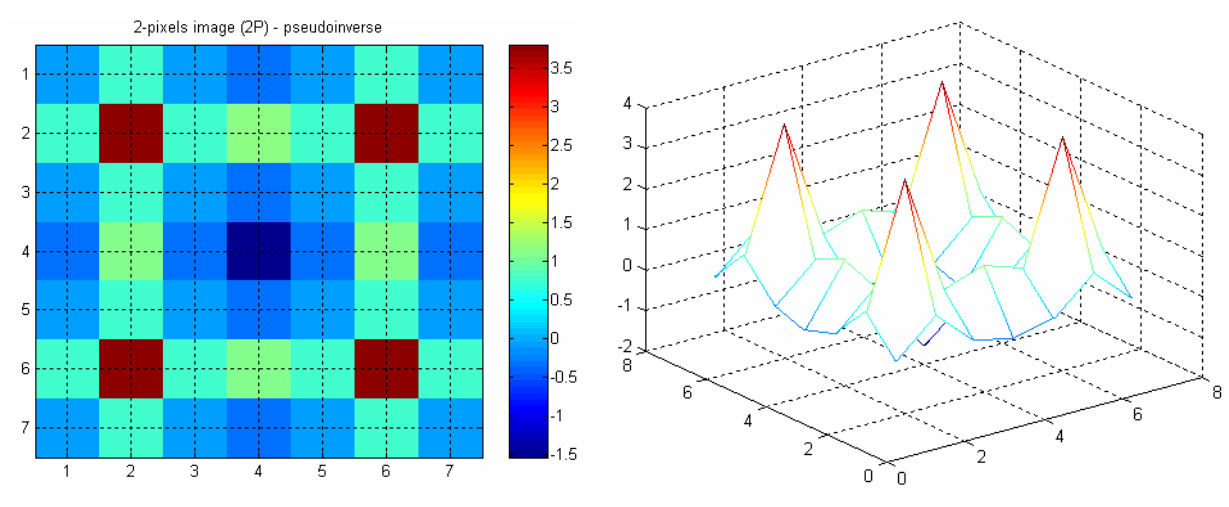
Figure 12. Two-particles image with two projections.